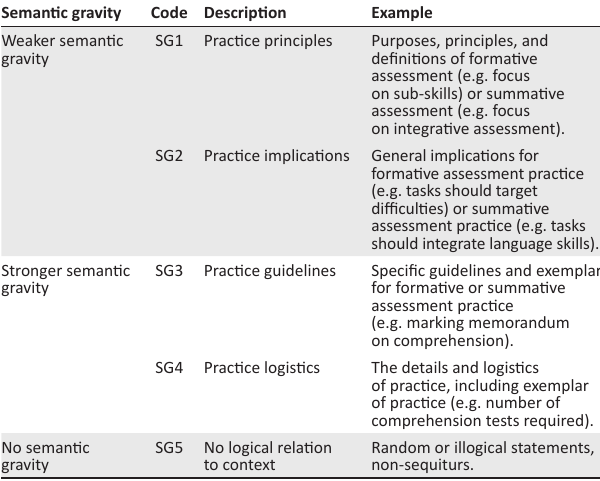
TABLE 2: A translation device for identifying semantic gravity in policy documents. Semantic